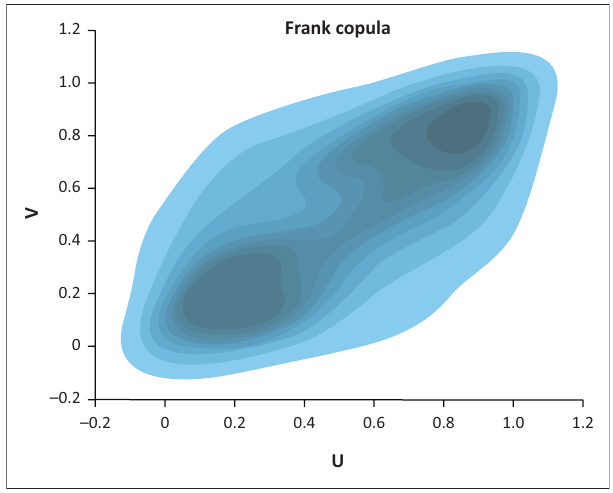
FIGURE 12: Contour plot of the dependence structure observed for SABOND10 and ZAR from 2013 to 2019 where the Pearson linear correlation has been generally stable around the 50 %